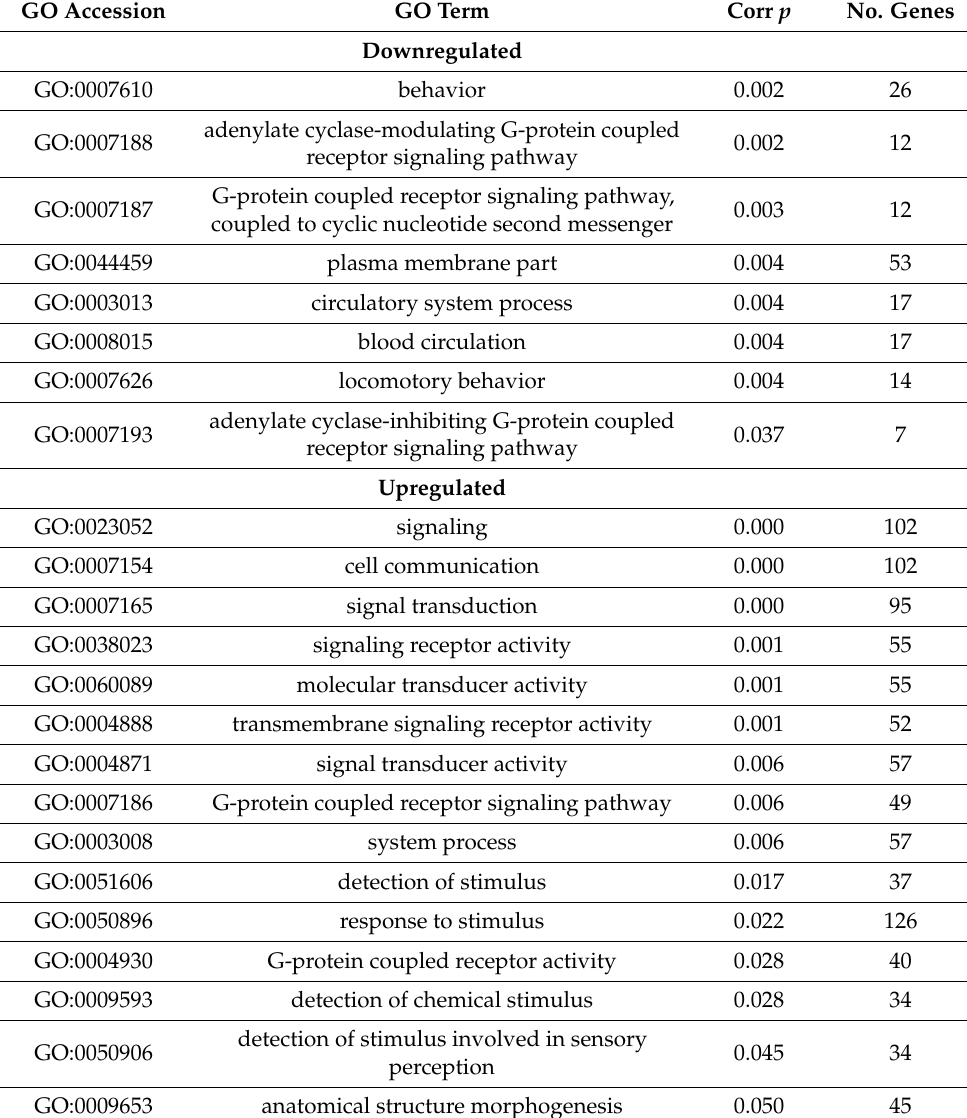
Table 2. GO terms significantly enriched from differentially expressed genes between rats with depressive-like behavior and control group in the